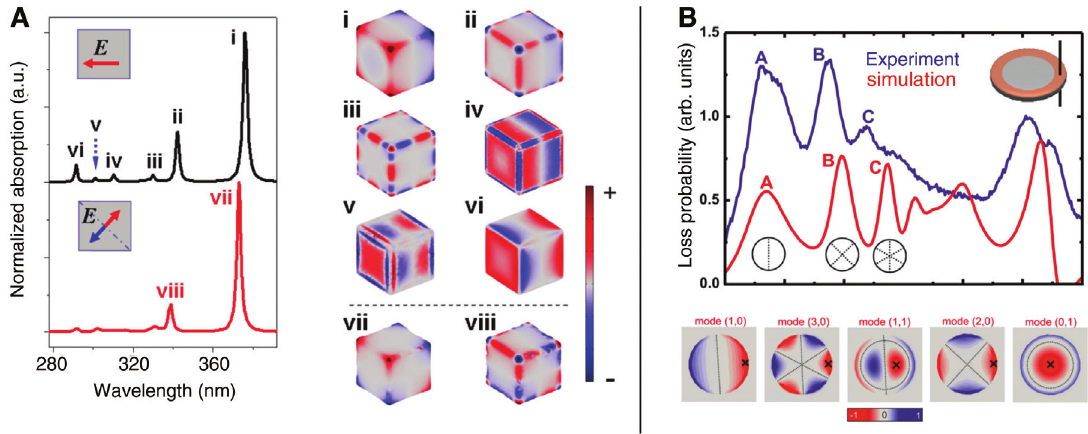
Figure 2: (A) Localized surface plasmon modes of a silver nanocube of 3 nm side length, in air [12]. Modes i to vi are bright modes with non- zero dipolar momentum; modes vii and viii are dark modes with no net dipolar momentum; (B) top: EELS spectrum of silver nanodisks for an electron beam focused near the edge of the particle; bottom: distribution of the surface charges associated with each LSP mode of the nanodisk identified as a maximum in the EELS spectra [13]. Reprinted with permission from Nano Lett., 2011, 11 (4), pp 1657–1663 and